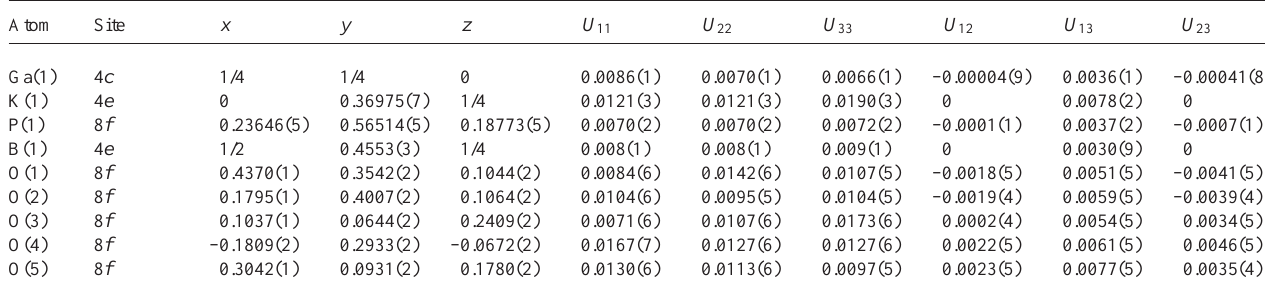
Table 3. Atomic coordinates and displacement parameters (in Å 2 )